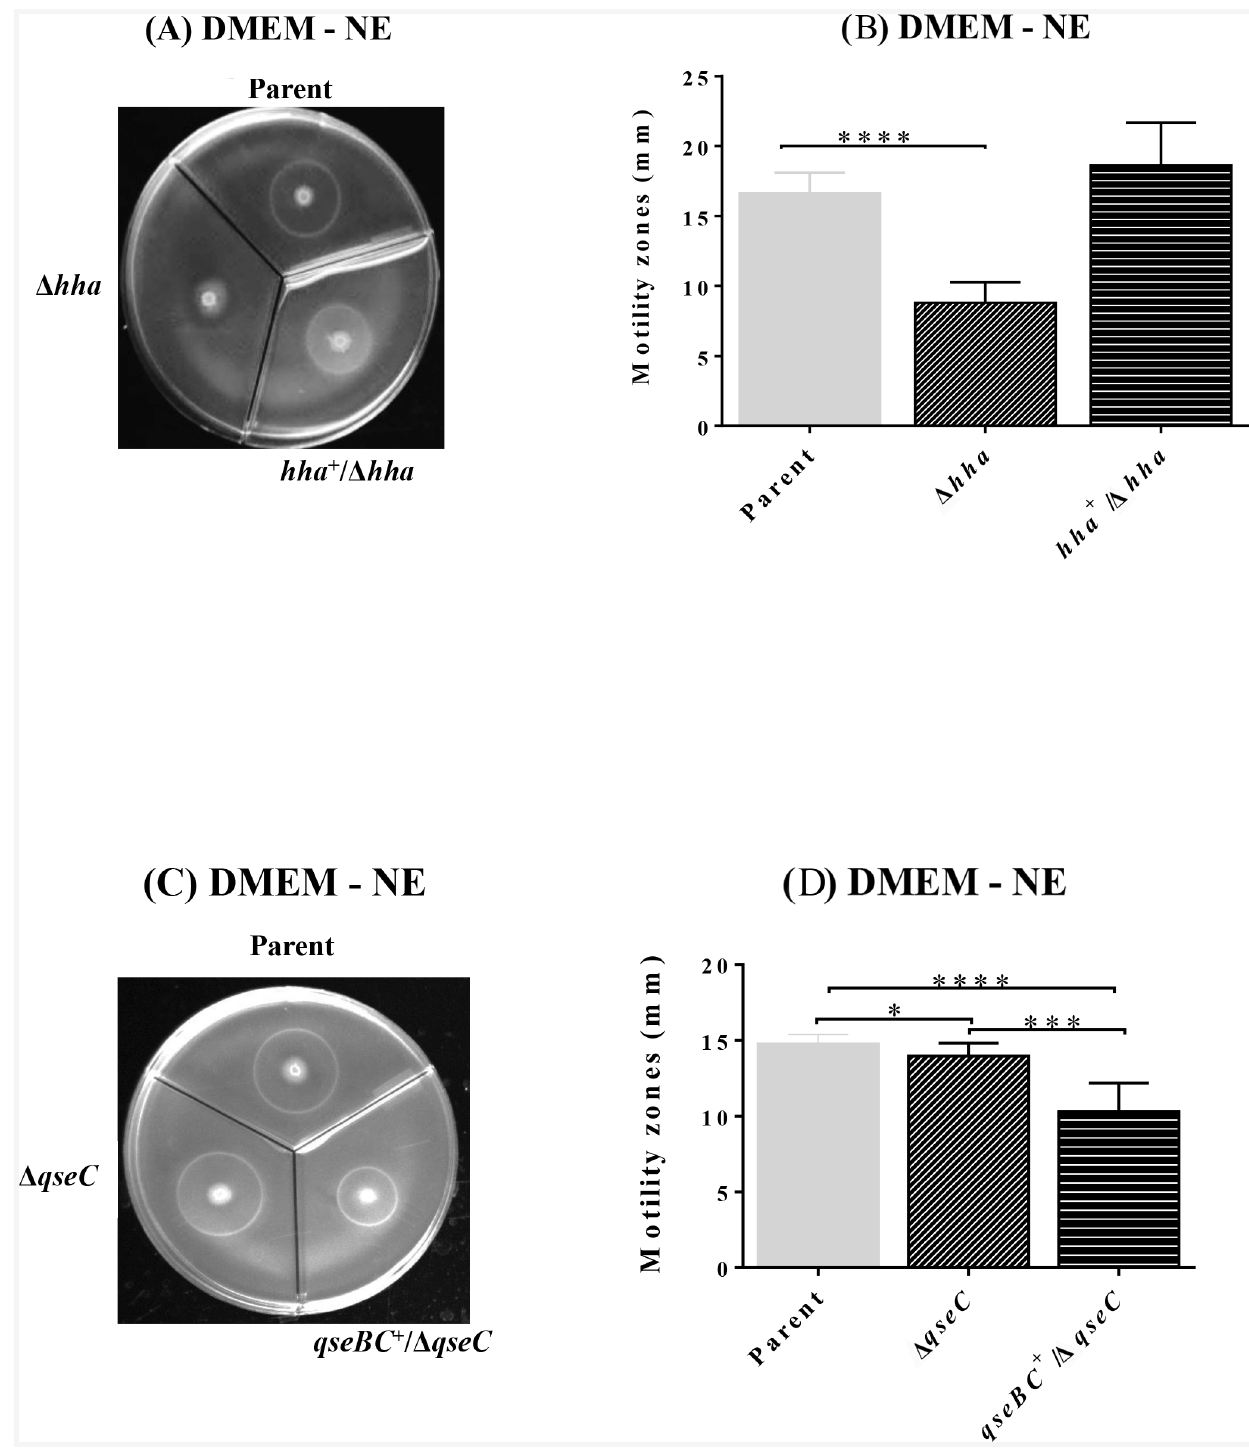
Figure 1. Relative effects of the hha and qseC deletions on bacterial motility. Three biological and a total of nine technical replicates of the overnight bacterial cultures of each strain were standardized to equivalent optical densities ( A 600 nm =4.00) and spotted in 2 m l aliquots on the motility agar plates containing or lacking norepinephrine (NE). Figures 1A and 1B show the motility zones produced around the point of bacterial inoculations and plot of their corresponding diameters (mm), respectively, for hha ( D hha ), hha -complemented ( hha + / D hha ) mutants, and the parent strain. Figures 1C and 1D show the motility zones produced around the point of bacterial inoculations and plot of their corresponding diameters (mm), respectively, for qseC ( D qseC ), qseC -complemented ( qseBC + / D qseC ) mutants, and the parent strain. Statistical significance of the differences in the motilities of the mutant and the complemented mutant relative to the parent strain is indicated by * ( p= 0.0177); *** ( p = , 0.003); **** ( p = , 0.0001).